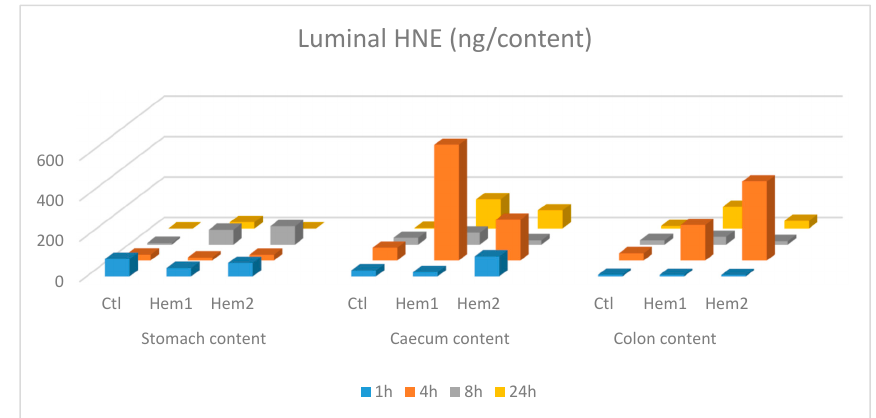
Figure 1. Amounts of 4-hydroxynonenal (HNE) (ng/content) measured in 3 intestinal contents, at 4 different time points, after oral gavage of sa ffl ower oil +/ − hemin. For each time point, 3 animals were sacrificed: Ctl had received only safflower oil at the starting time point (T0), while Hem1 and Hem2 had received a mixture of safflower oil + hemin at T0. The bars represent the amount of HNE in the intestinal content of one rat, at a specific time point. Antioxidants 2020 , 9 , x FOR PEER REVIEW